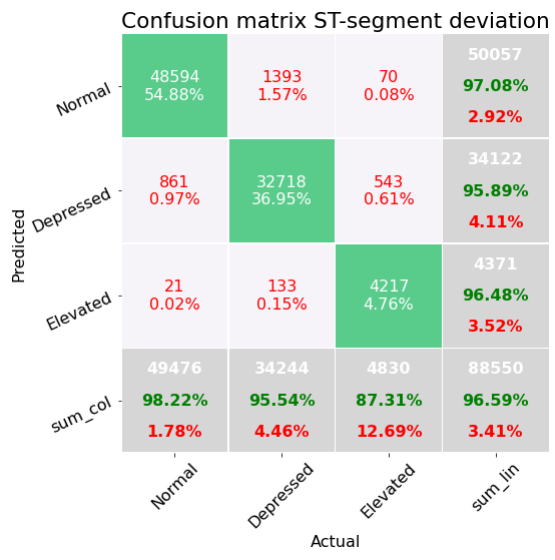
Figure 5. Confusion matrix on the modeling containing the features concerning statistical measure- ments, SQIs of the ECG beat and distance from the baseline at two different points after the J-point, 60 and 80 mV